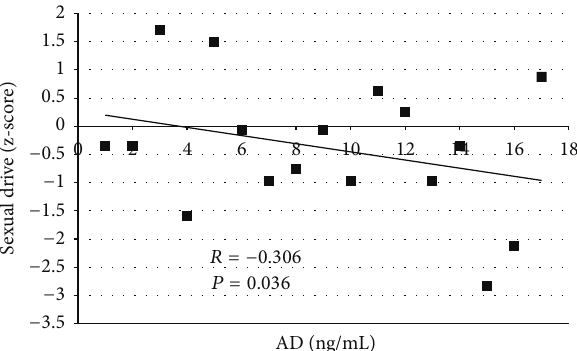
Figure 3: Correlation of androstenedione (AD) levels and 𝑧 -scores of “sexual drive” of the male Brief Sexual Function Inventory (BSFI) in male patients with congenital adrenal hyperplasia at baseline. Higher scores indicate less impaired